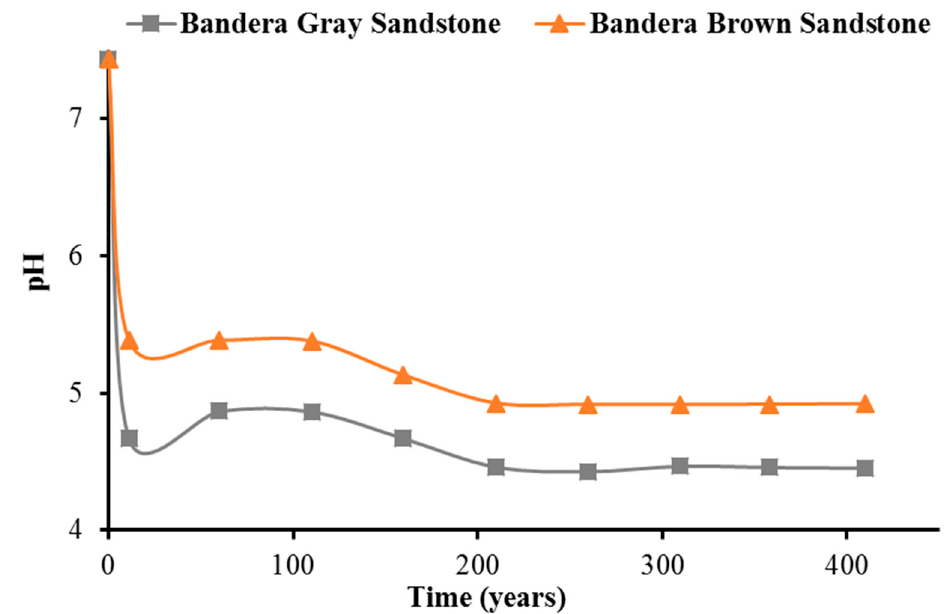
Figure 4. Brine pH for the high and low clay-content sandstone with storage time.